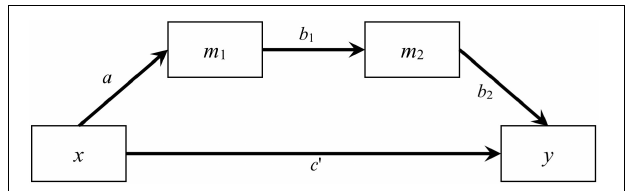
FIGURE 4 | A Serial Mediation Model with Two